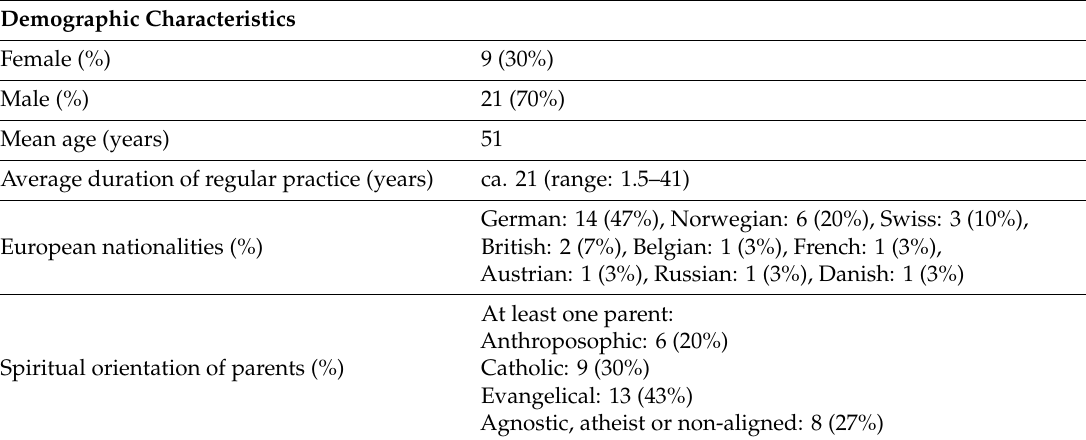
Table 1. Participant Demographics. Numbers indicate prevalence in the present sample (N = 30) except in the case where years are